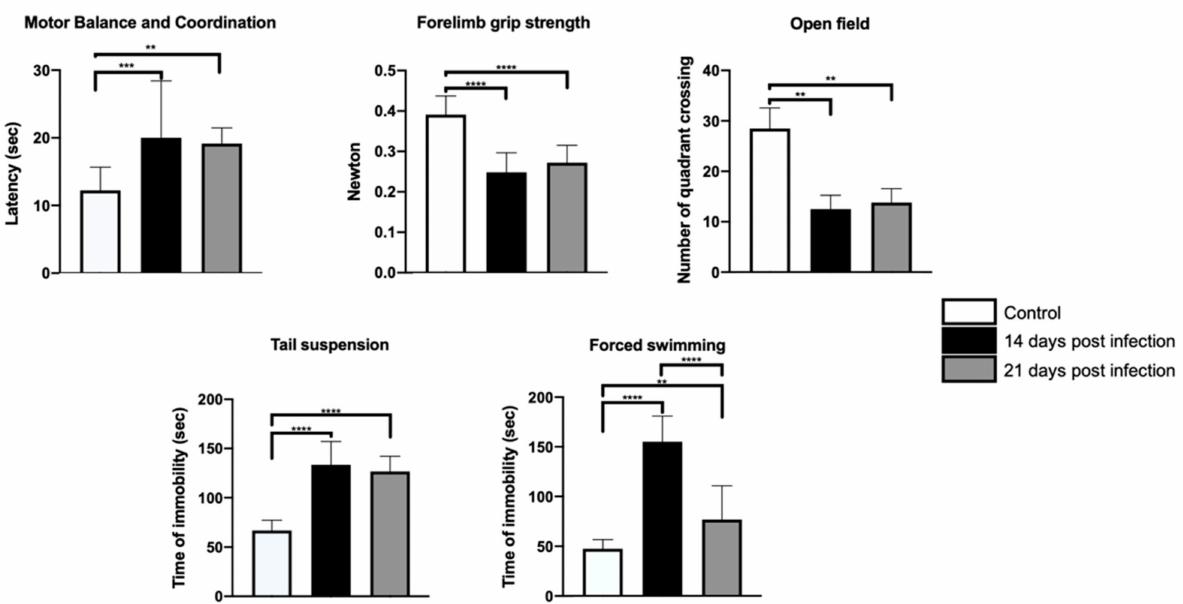
Figure 1. Parametrizing behavioral variables. Behavioral tests showed that the infected mice presented musculoskeletal alterations and changes in balance and motor coordination, decreased movement, and motivation. ANOVA tests were used for motor balance and coordination, tail suspension, and forced swimming tests. Kruskal–Wallis tests were used for forelimb grip strength and open field tests. Statistical significance was recognized when p < 0.05. Statistical significance is represented as follows: ** p < 0.01; *** p < 0.001; **** p <